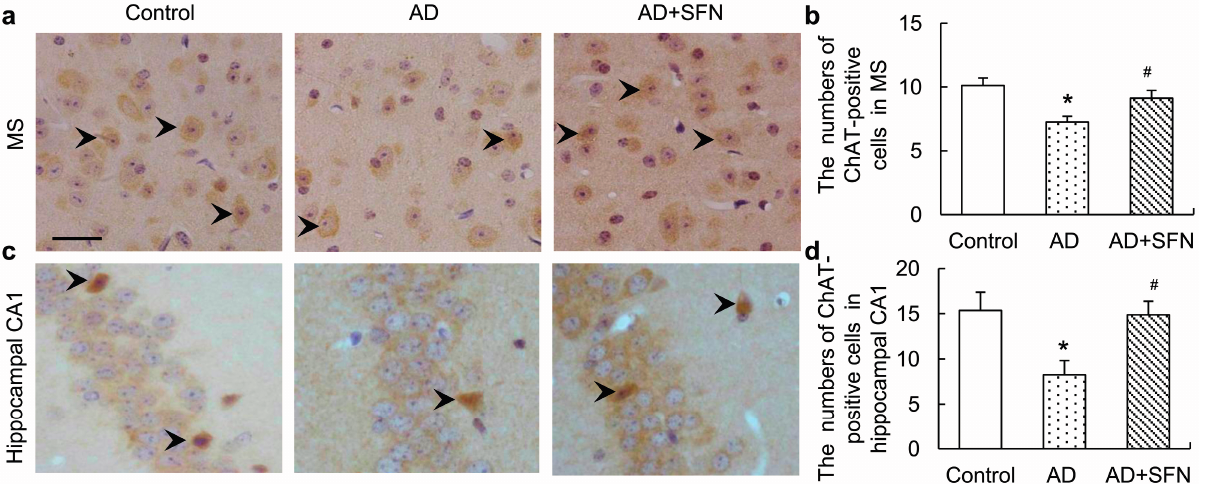
Figure 4. Immunohistochemistry assays of cholinergic neurons in the medial septal (MS) and hippocampal CA1 regions. Brown immunoreactive cells imply the cholinergic neurons in mice brain (see arrows, bars = 50 μ m). The numbers of cholinergic neurons were markedly decreased in the MS ( a ) and hippocampal CA1 ( c ) regions of AD-like mice compared with controls and AD + SFN-like mice. However, the numbers of cholinergic neurons in these regions did not differ significantly between groups of control and AD-like mice with sulforaphane treatment; ( b ) and ( d ) showed quantitative assessments of choline acetyltransferase (ChAT) immuno-positive neurons in MS and hippocampus CA1, respectively. ( n = 8; means ± S.E.M.; One-way analysis of variance followed by post hoc least significant difference multiple comparison tests; * p < 0.05 versus control, # p < 0.05 versus AD; magnify 400×; all cholinergic neurons in hippocampus CA1 were counted; number of cholinergic neurons of each field of vision in the MS was